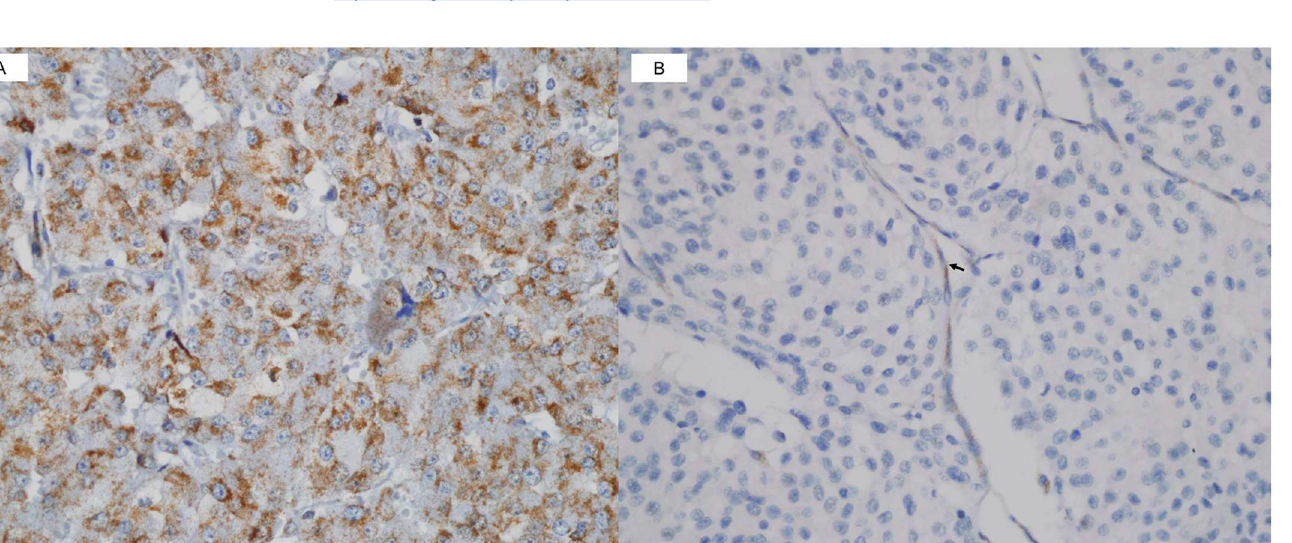
PLOS ONE | https://doi.org/10.1371/journal.pone.0187398 November8,